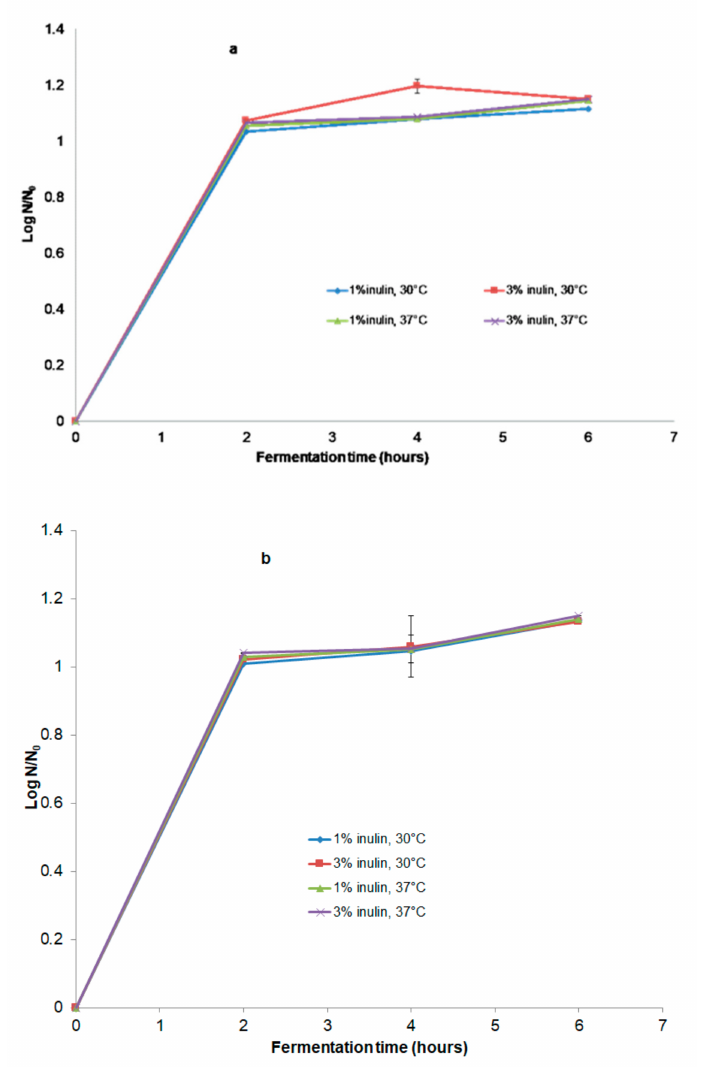
Figure 1. Probiotic viability during fermentation. ( a ) Samples with SBS; ( b ) Samples with